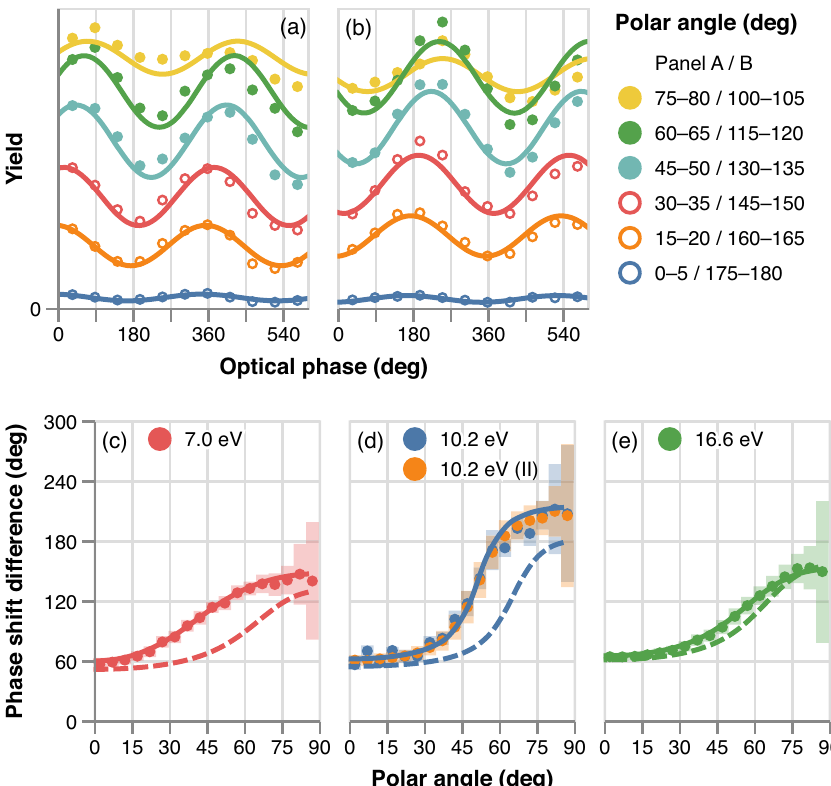
FIG. 2. Upper: Typical photoelectron yields I ð θ ; ϕ Þ as a function of optical phase ϕ at intervals of polar angles θ . The signal is integrated over the 5° intervals shown on the right. The curves are not shifted; thus, their vertical position reflects directly the value A 0 in Eq. (4). The photoelectron kinetic energy is 7.0 eV. Circles are experimental results; lines are sinusoidal fits of the experimental results. Lower: Extracted phase shift differences as a function of the polar angles, for four datasets and three photoelectron kinetic energies: left (c), 7.0 eV; middle (d), 10.2 eV; right (e), 16.6 eV. Circles are experimental results; shaded areas show their uncertainties. Dashed lines, perturbation theory; solid lines, real-time ab initio theory. Note that the curves in (a) and (b) oscillate in antiphase, because they correspond to emission directions on opposite sides of the photon propagation